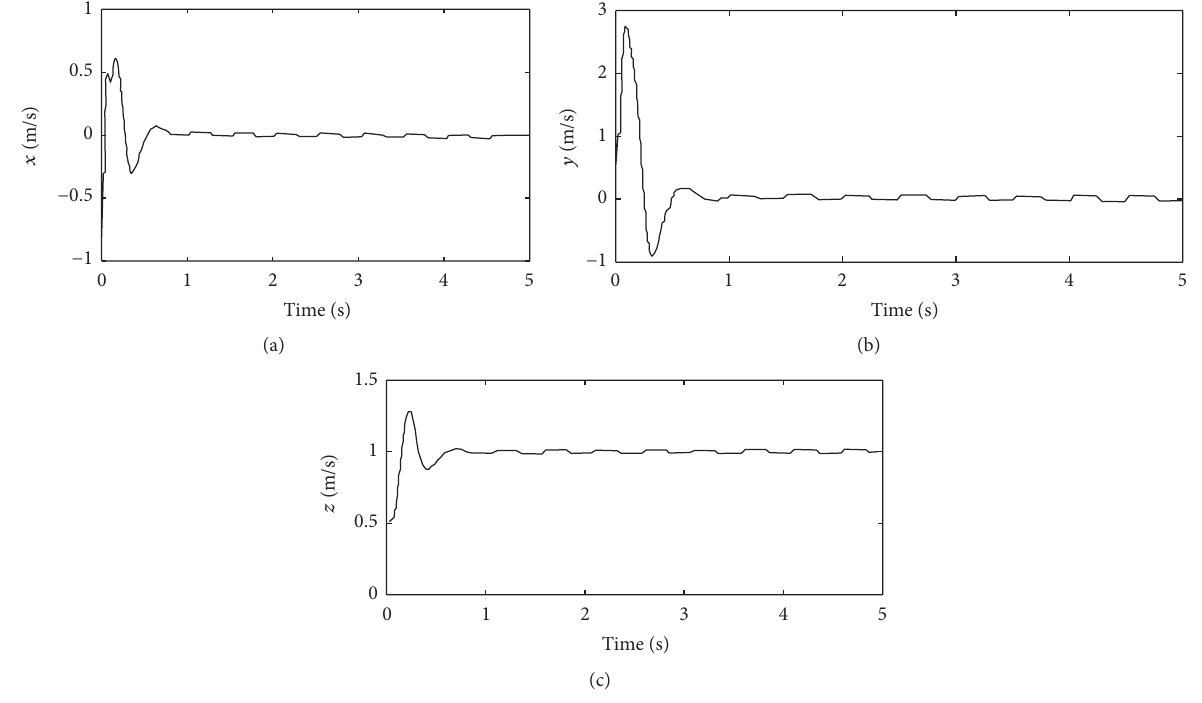
Figure 19: Position rate and altitude of trirotor